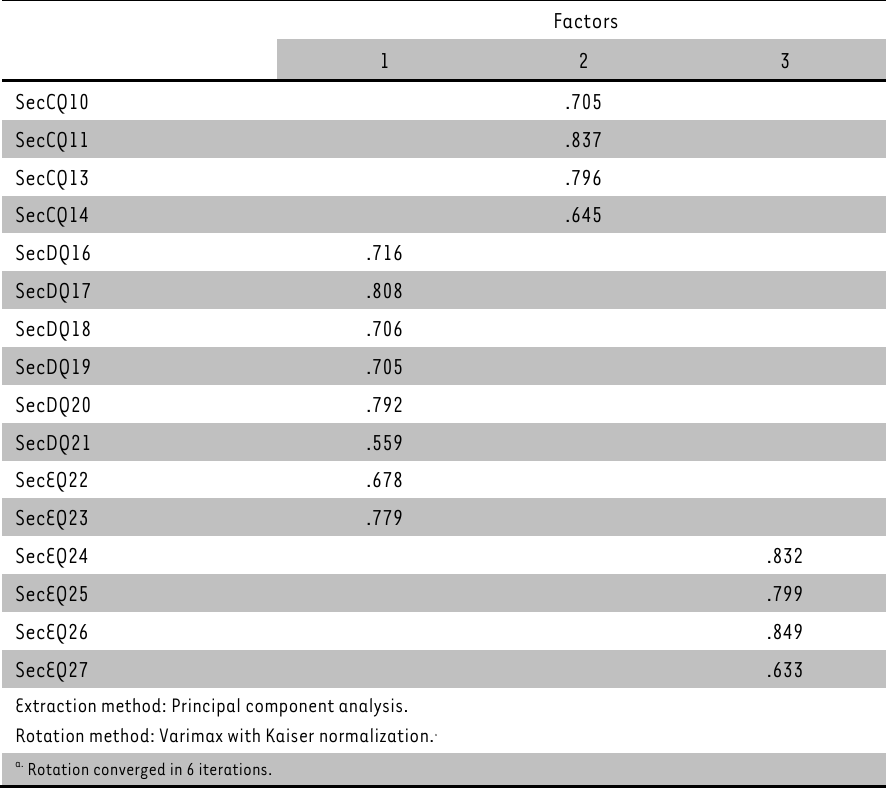
TABLE 2: Principal component analysis – Rotated component matrix